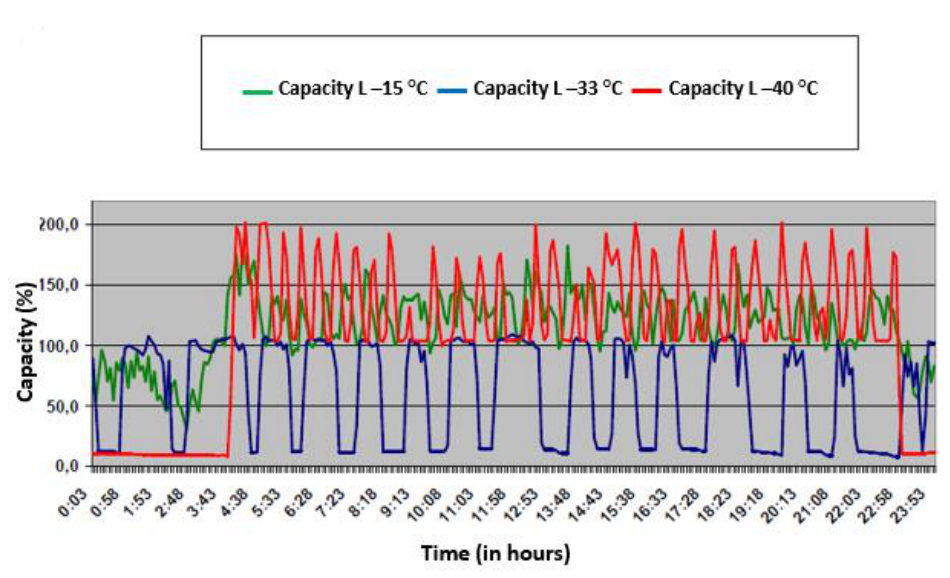
Figure 7. Operation profile for a typical day in February.